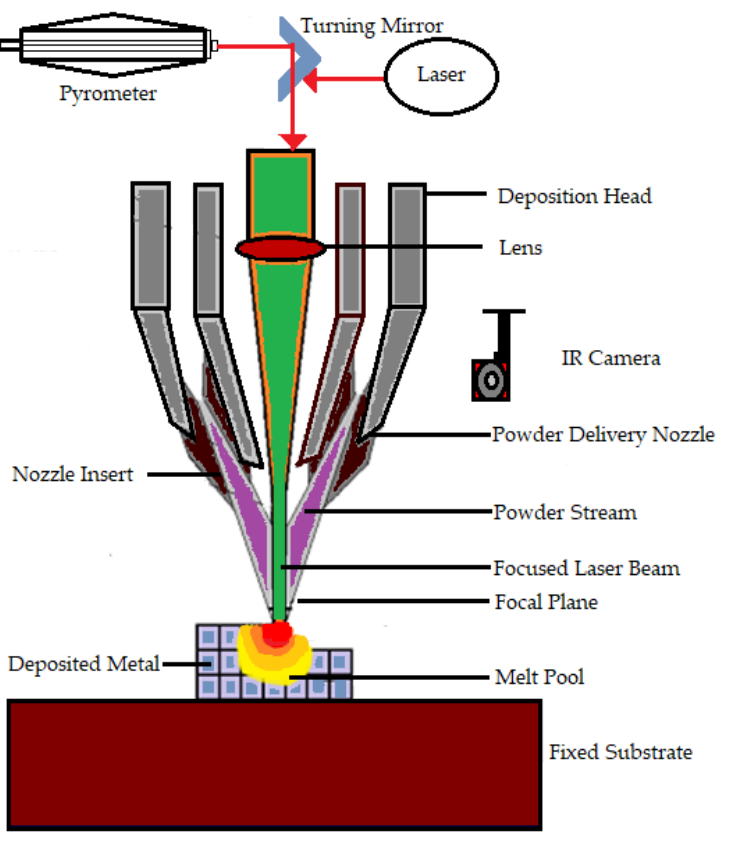
Figure 1. Working of the direct energy deposition technique.